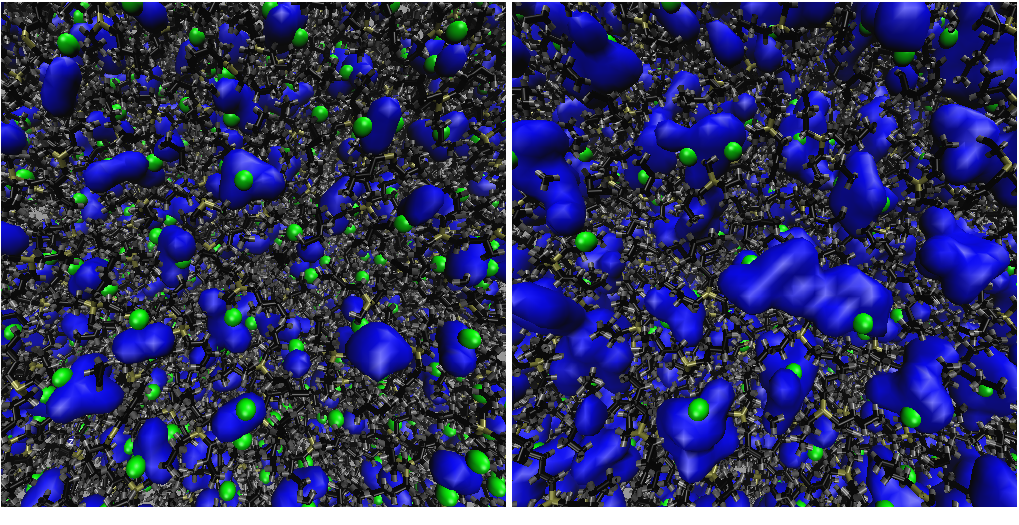
’s), within the same molecule 4